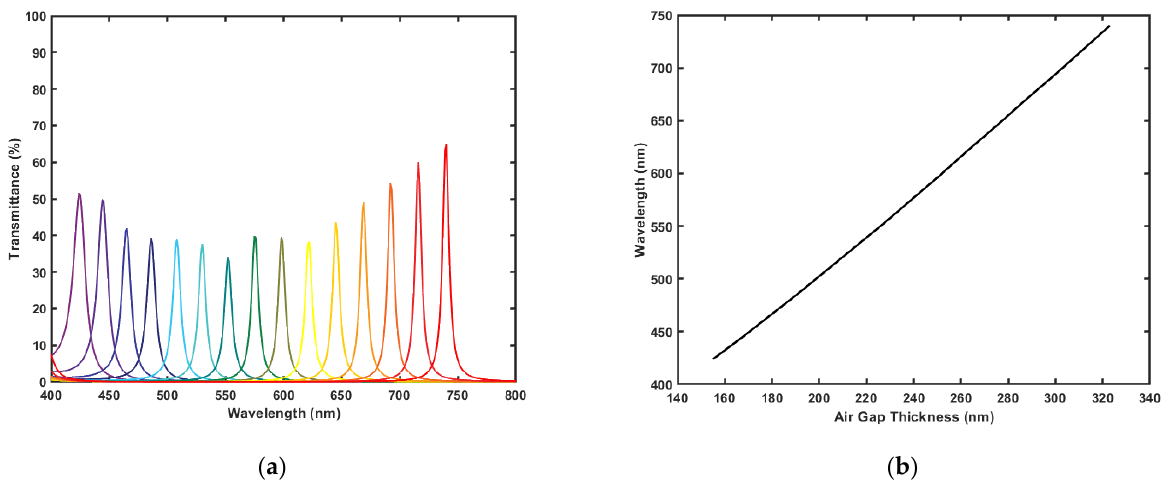
Figure 5. Results generated by MATLAB code for the design optimized for minimum FWHM: ( a ) Transmission spectra of the filter at different air gap values; ( b ) Resonance wavelength versus the tuned air gap thickness of the